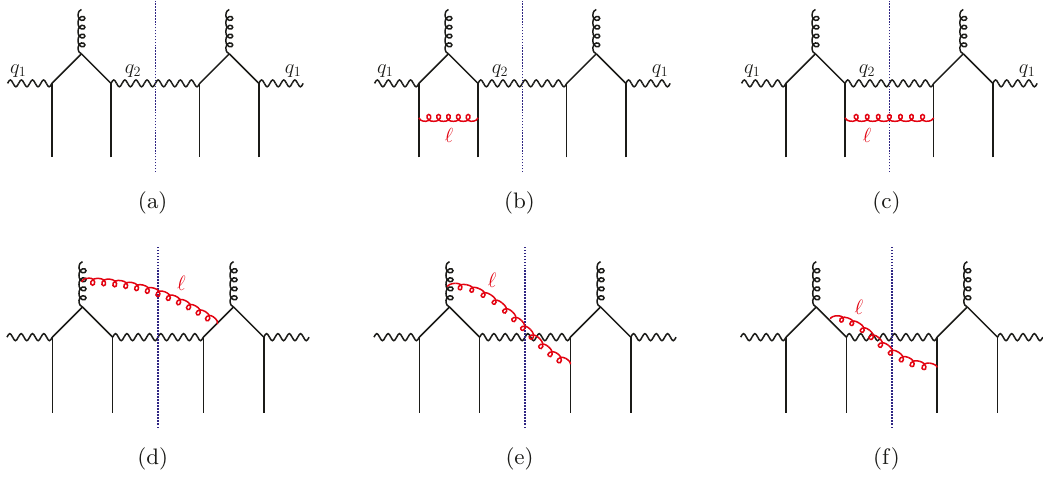
Figure 8 . LO and NLO graphs for the 2v1 mechanism, with the blobs for the hadronic matrix elements omitted as in figure